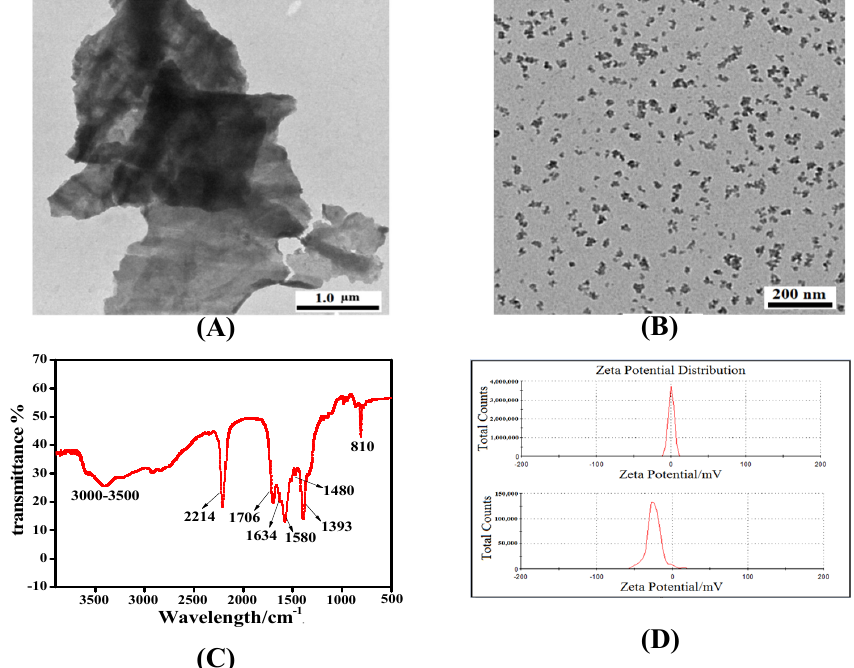
Figure 1. ( A ) TEM image of bulk- g -C 3 N 4 , ( B ) TEM image of carboxylated- g -C 3 N 4 NPs, ( C ) FTIR spectrum of carboxylated- g -C 3 N 4 NPs, and ( D ) ZP of bulk- g -C 3 N 4 (top) and carboxylated- g -C 3 N 4 NPs (bottom).